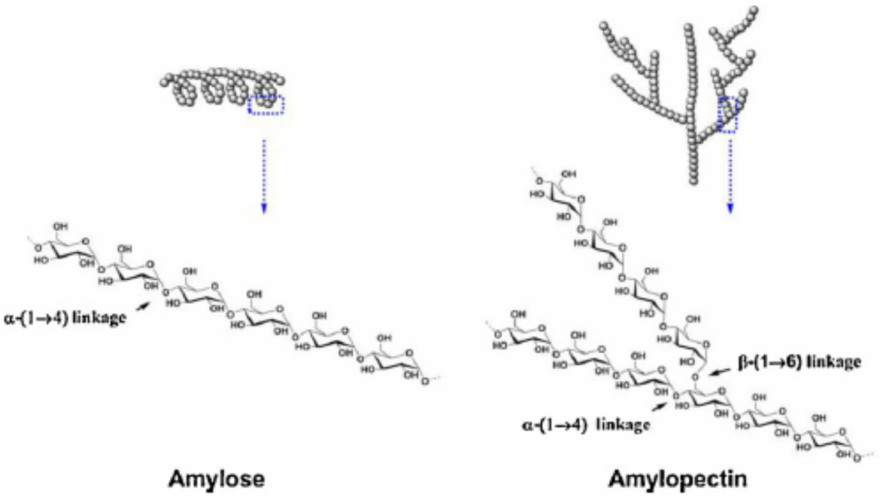
Figure 8. Illustration of the structure of amylose and amylopectin. Reproduced from Fan and Picchioni